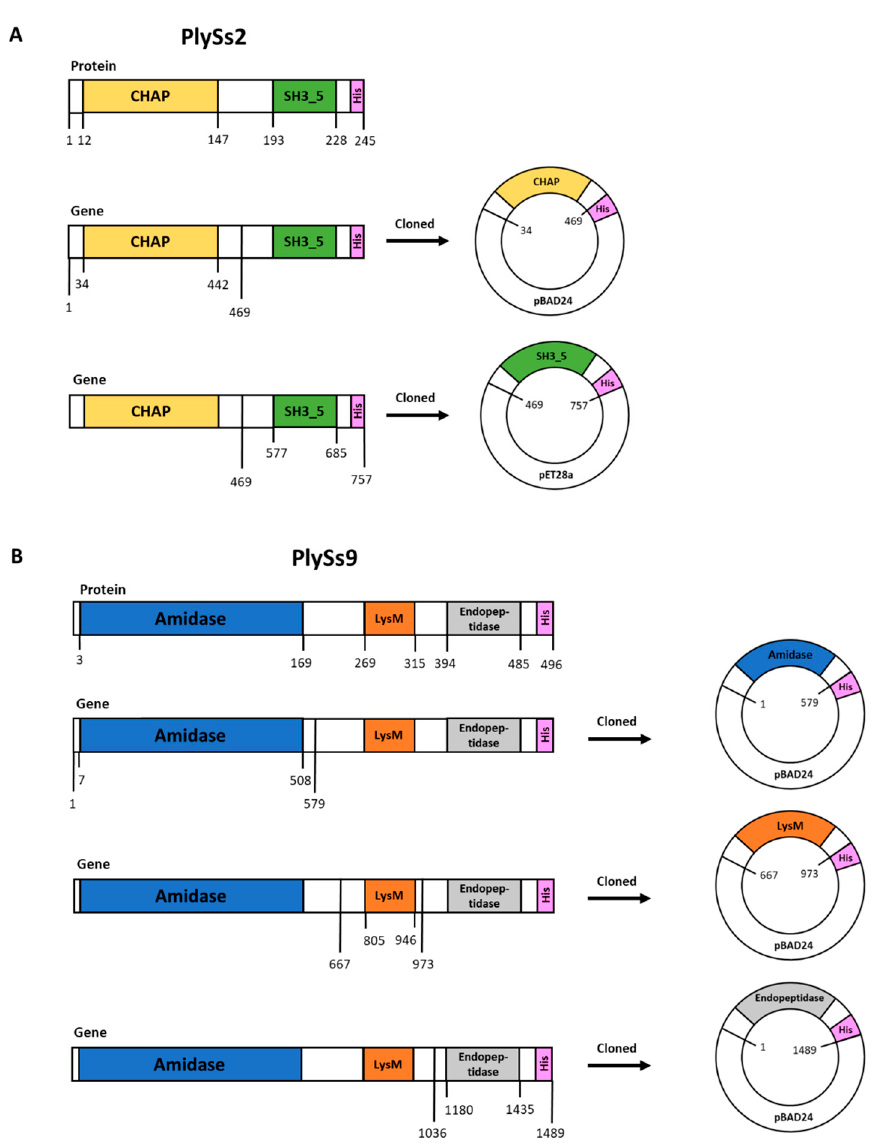
Figure 1. Schematic representation of the parental PlySs2 ( A ) and PlySs9 ( B ) protein sequences and their respective synthesized genes. PlySs2 consists of an N-terminal histidine-dependent amino hydrolase / peptidase (CHAP) and a C-terminal SH3_5 cell binding domain (CBD). PlySs9 has a LysM-based CBD and two catalytic domains; an N-terminal N-acetylmuramoyl-L-alanine amidase and a C-terminal endopeptidase. Subdomain boundaries regarding cloning into a pBAD24 or pET28a vector were selected to correspond to the linker regions such that predicted α -helices and β -sheets were not disrupted. To aid in downstream purification, the coding sequence for a polyhistidine tag was incorporated into the reverse primers used to amplify subdomain sequences (see also Table 2).